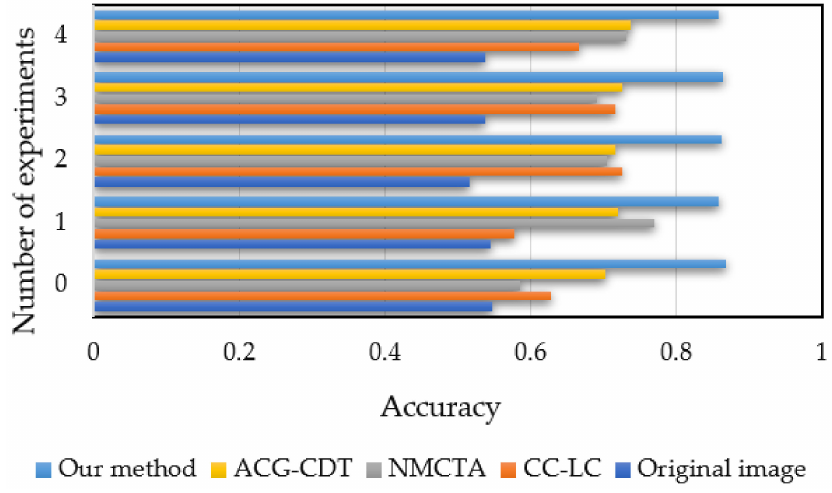
Figure 18. Accuracy of different color correction methods on the test set.